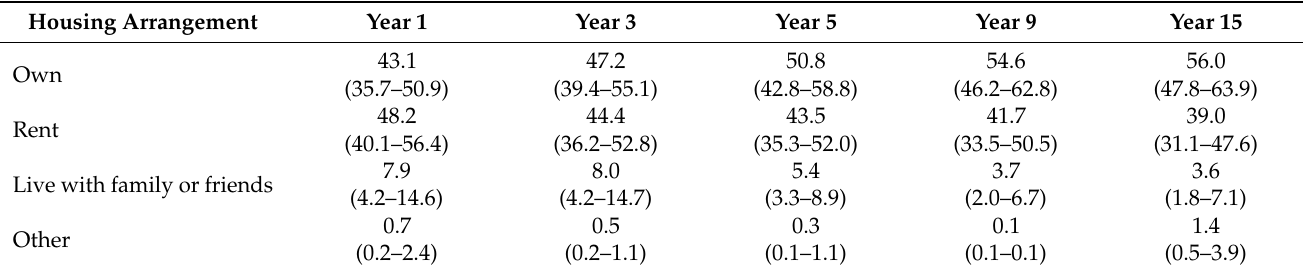
Table A2. Weighted percentages of housing arrangements from Year 1 to Year 15 among US mothers married at childbirth, Fragile Families and Child Wellbeing Study ( n =